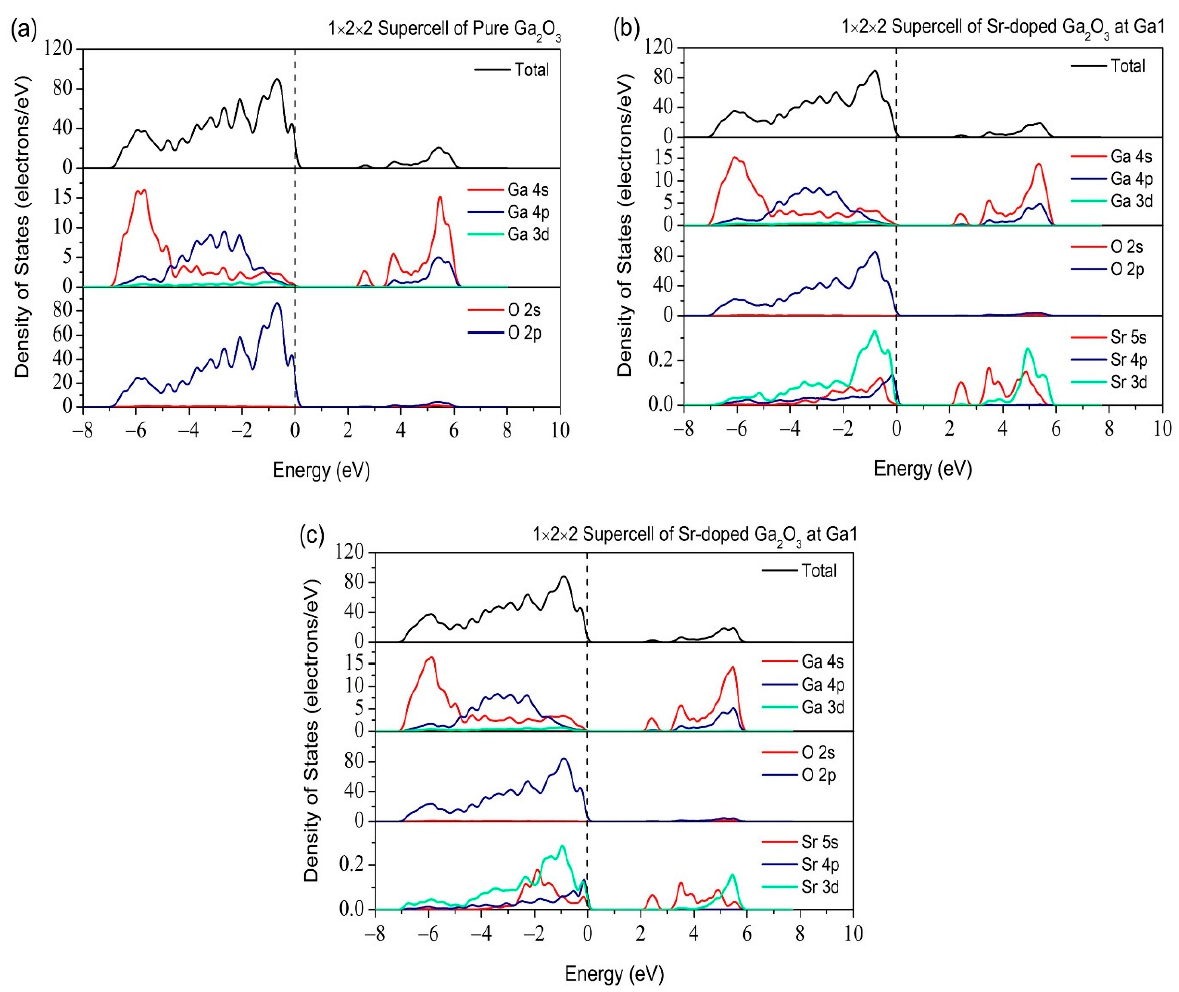
Figure 10. Total and Partial density of states of ( a ) pure β -Ga 2 O 3 , ( b ) Sr-doped β -Ga 2 O 3 at Ga1, and ( c ) Sr-doped β -Ga 2 O 3 at Ga2 in 1 × 2 × 2 supercell.